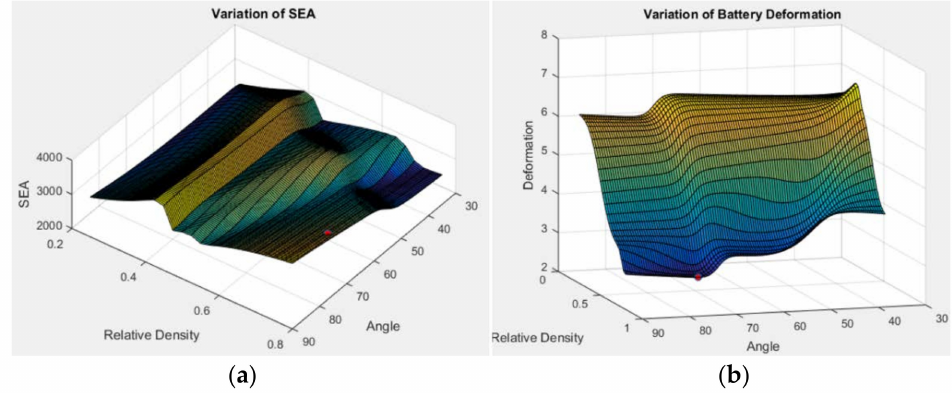
Figure 12. The variation response of: ( a ) SEA; ( b ) deformation, δ as functions of θ and ρ . The effects of the yield strength on the SEA and deformation, to represent material aspects, are shown in Figure 13a,b, respectively. The point marks show the data obtained from the FEM simulations, while the lines show the results of ANN prediction. As shown, the behaviors show that the effect of the material on the geometrical structure does not have a regular pattern.